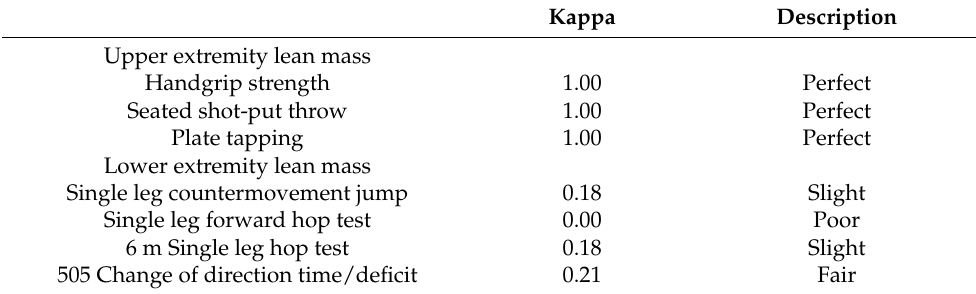
Table 4. Kappa coefficients indicating the consistency in direction between the dominant lean mass value and the dominant performance value across unilateral tests for the high-level female tennis players (N =